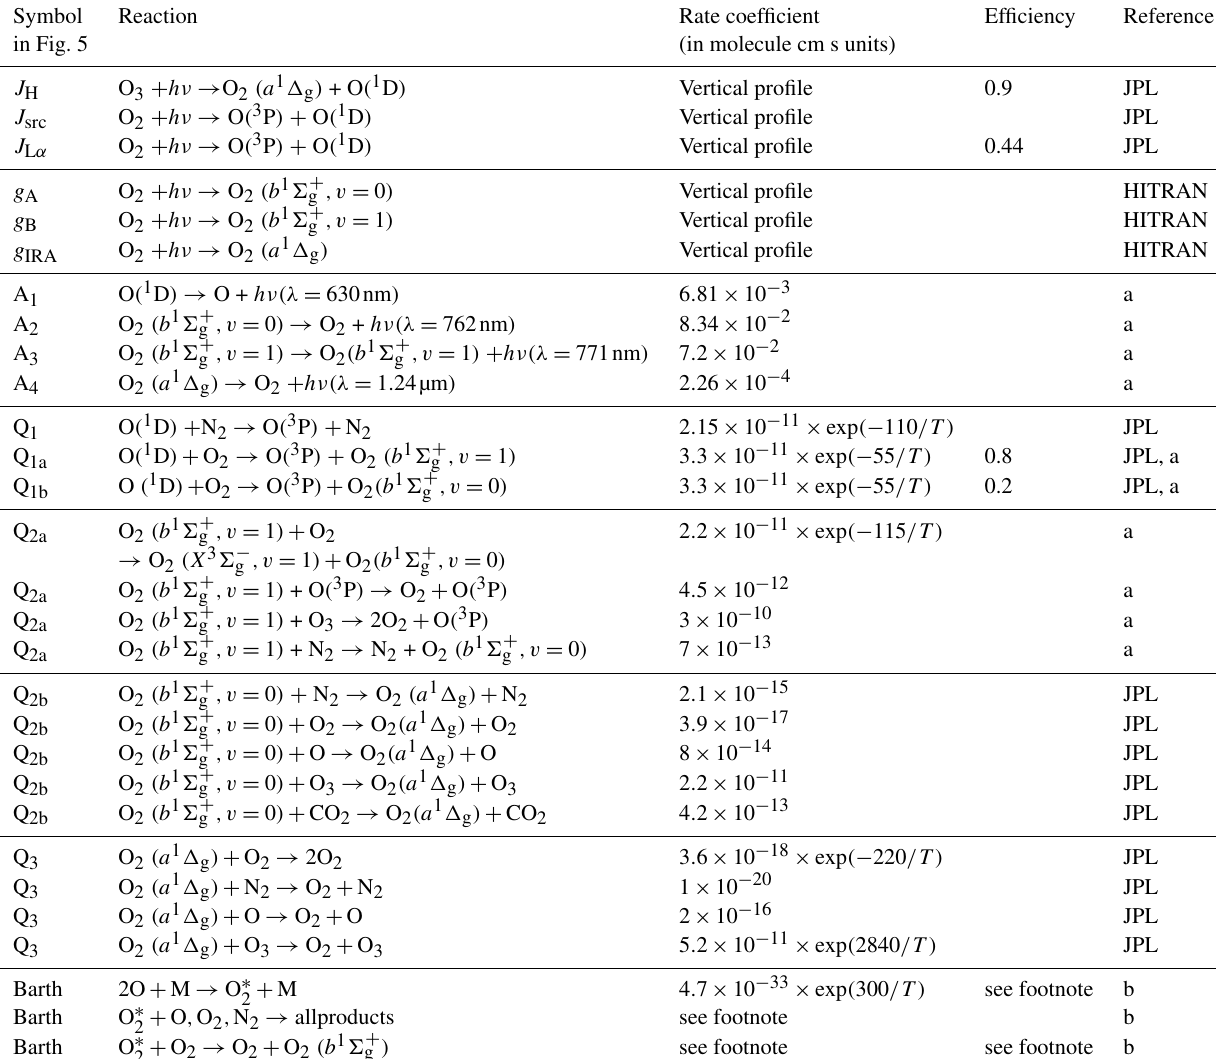
Table A1. Reactions and their coefficients included in the photochemical